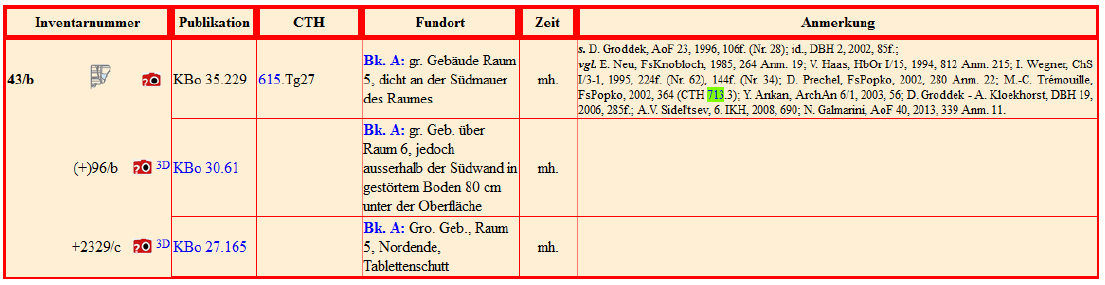
Figure 7. Integration of the 3D viewer in a representative query result of the concordance in the Hethitologie-Portal